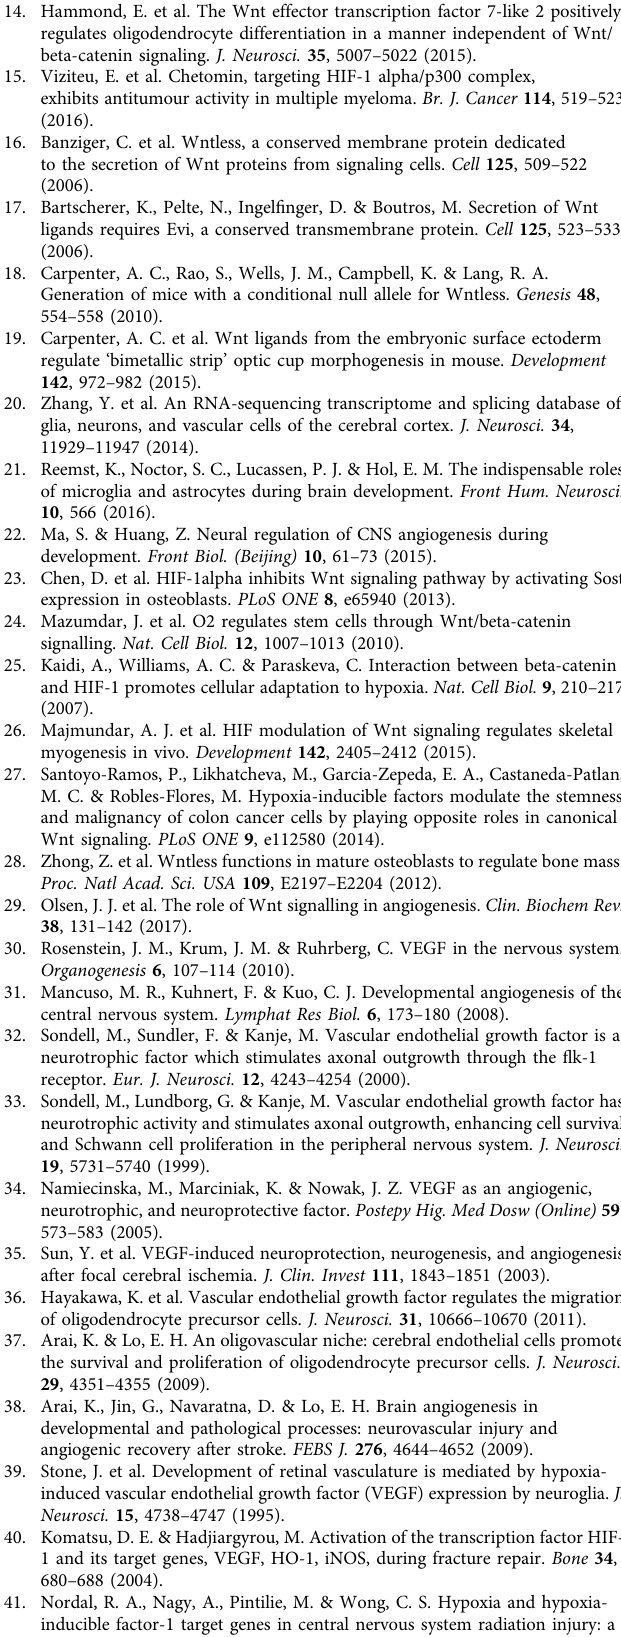
RNAs were analyzed by the Nanodrop one C microvolume UV-Vis Spectro- photometer (ND-ONEC-W, Thermo Fisher Scienti fi c). cDNA was synthesized by